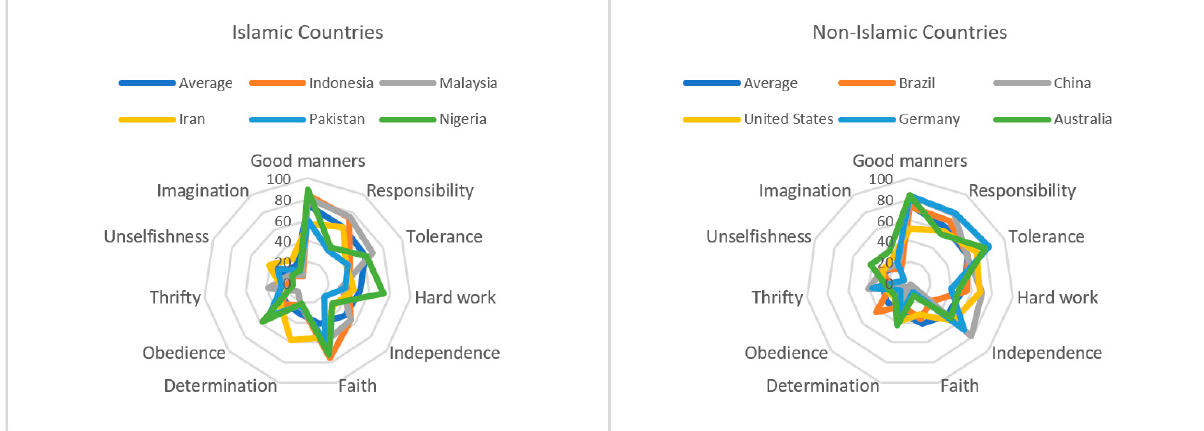
Figure 6. Qualities to develop for future generation by Asian and Non-Asian regions.